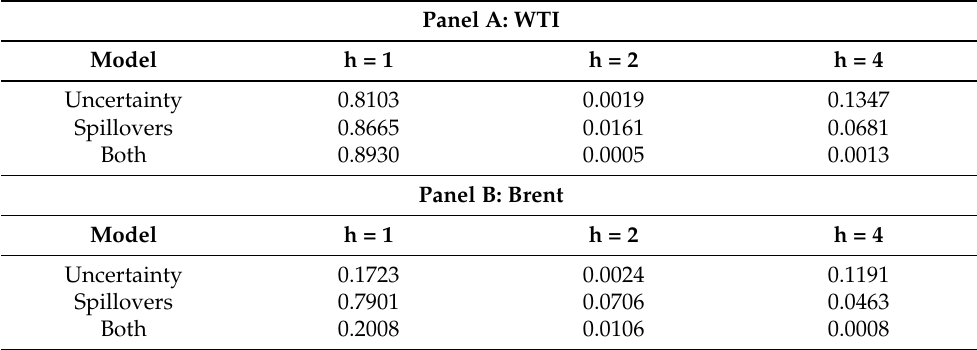
Table 1. Baseline forecasting results.